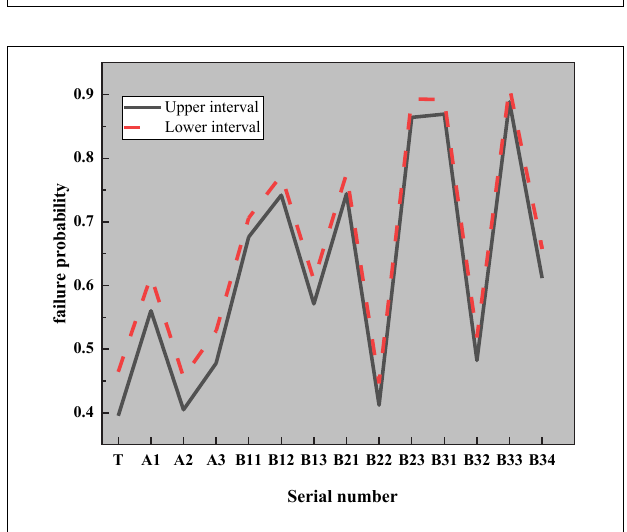
FIGURE 19 | Event probability diagram of each layer.